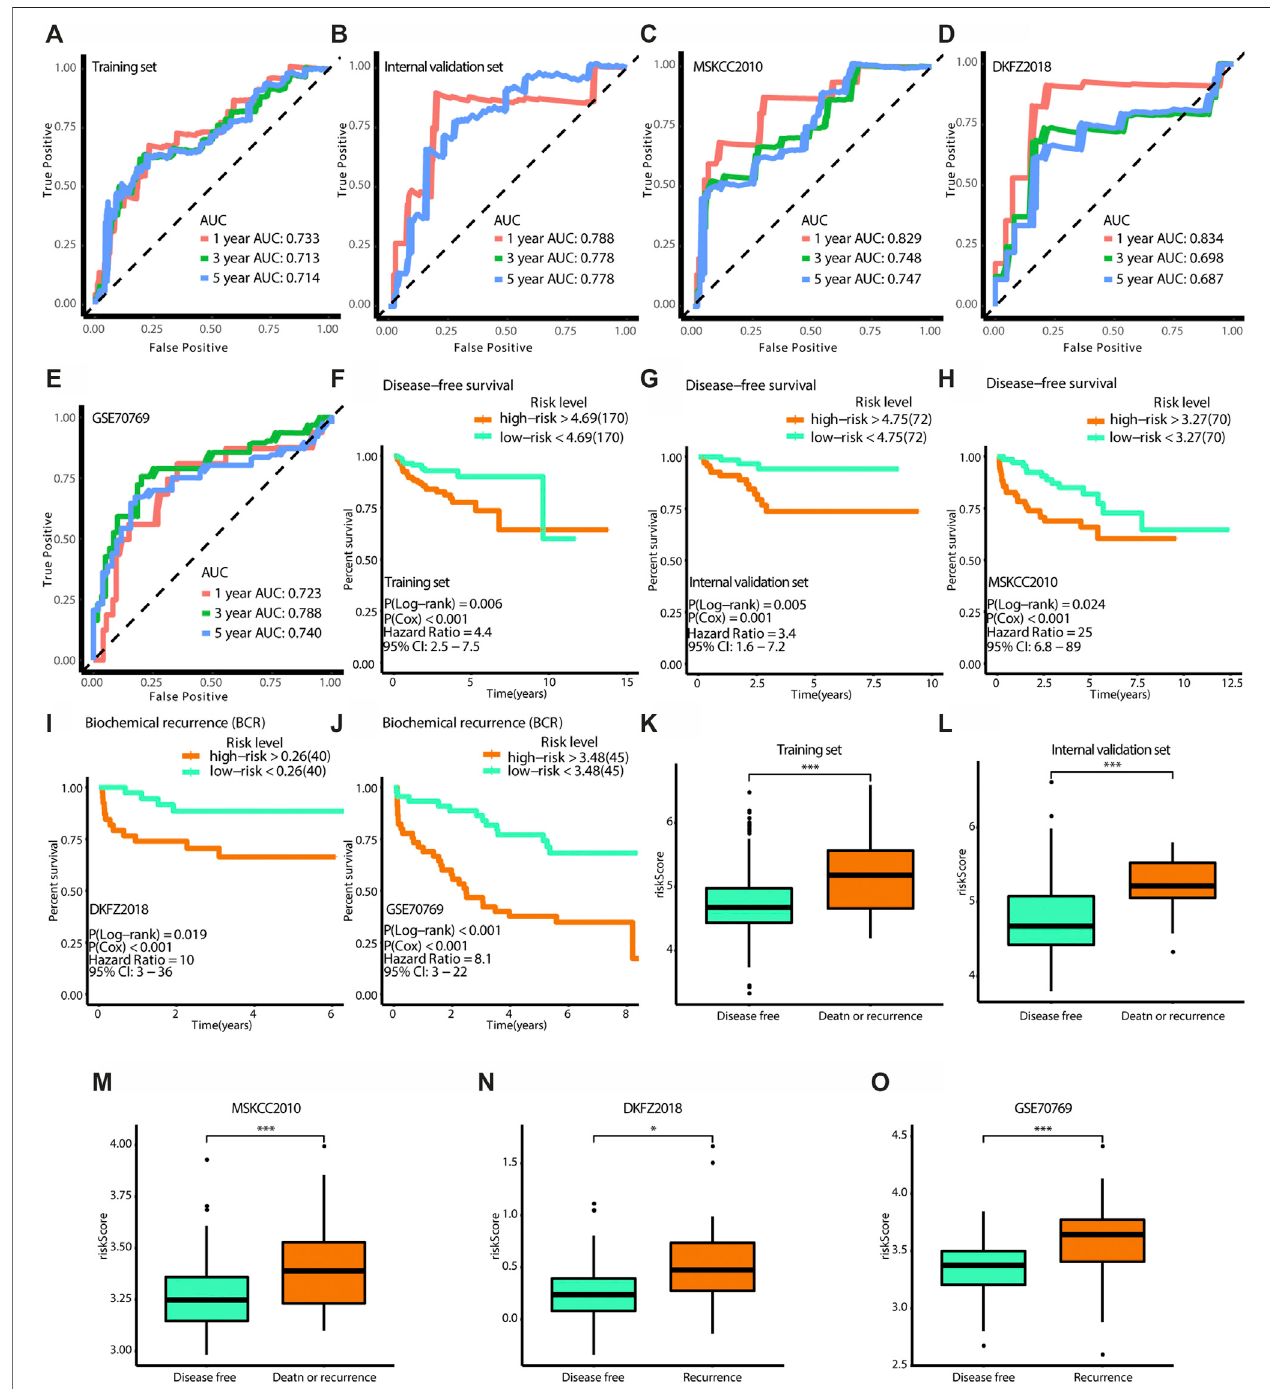
FIGURE 8 | Veri fi cation of the effectiveness of the model. (A – E) The ROC curves of 1-year, 3-year, and 5-year follow-up time. (F – J) Kaplan-Meier curves for survival analysis. (K – O) The boxplots show the difference of risk score between survival outcomes. (A , F , K) The results in the training set. (B , G , L) The results in the internal validation set. (C , H , M) The results in MSKCC 2010. (D , I , N) The results in DKFZ 2018. (E , J , O) The results in GSE70769. (AUC, area under curve. * means p < 0.05, ** means p < 0.01, *** means p < 0.001, ns means p > 0.05, and p < 0.05 is de fi ned as statistically signi fi cant. And p < 0.05 is de fi ned as statistically signi fi